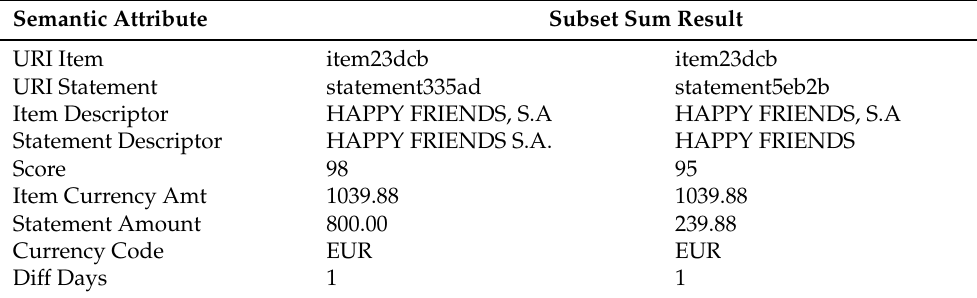
Table 11. Results of multiple movements for an invoice.